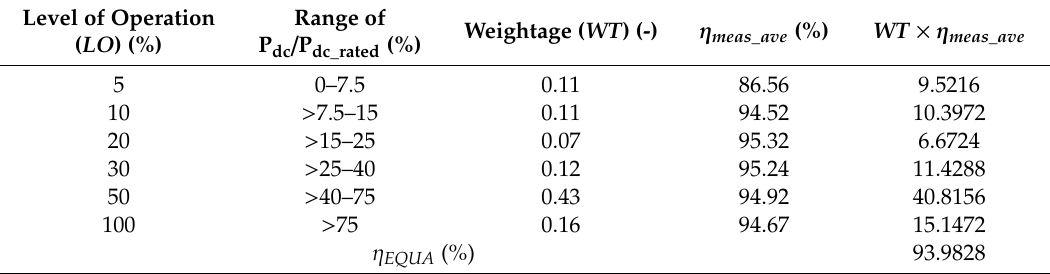
Table 8. Weighted e ffi ciency for K7900TL inverter when G = Gi and T = 25 ◦ C with individual weightage.